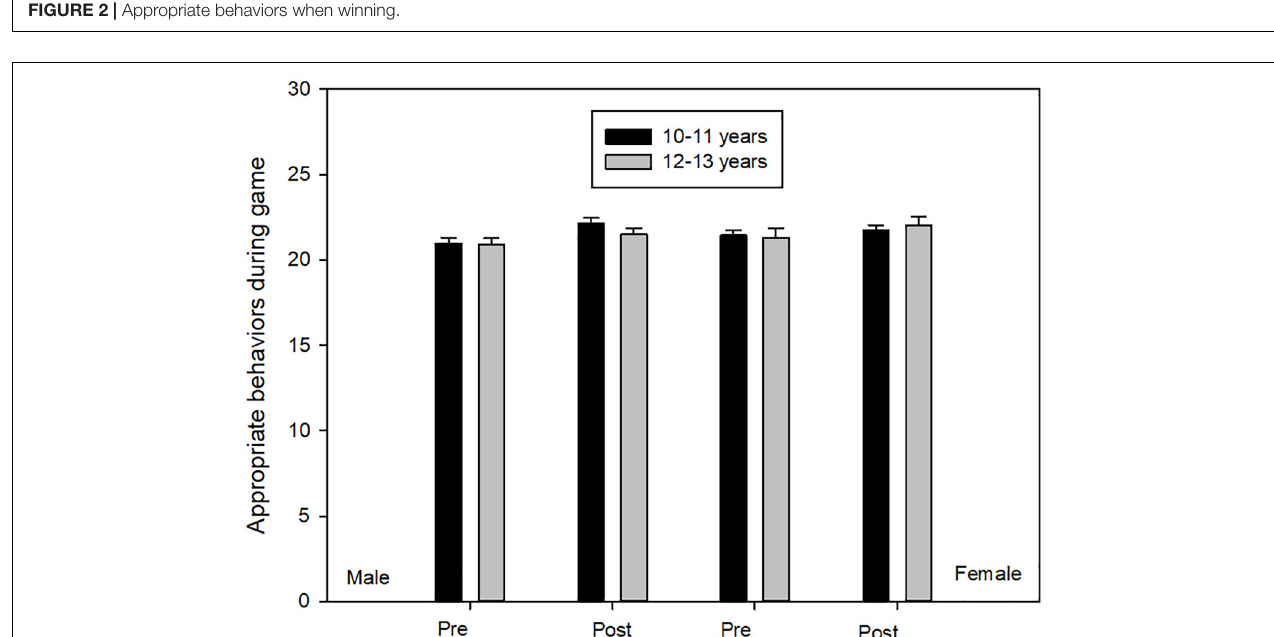
FIGURE 3 | Appropriate behaviors during